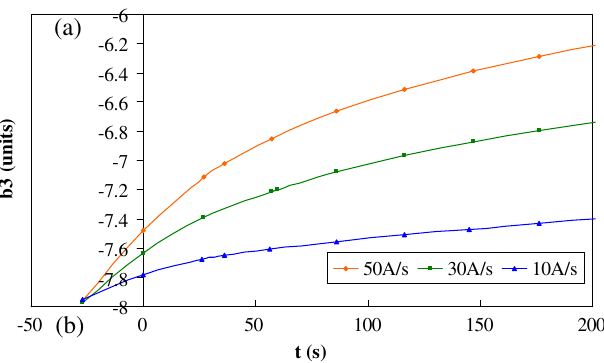
FIG. 4. (Color) Extrapolation of the decay at the beginning of